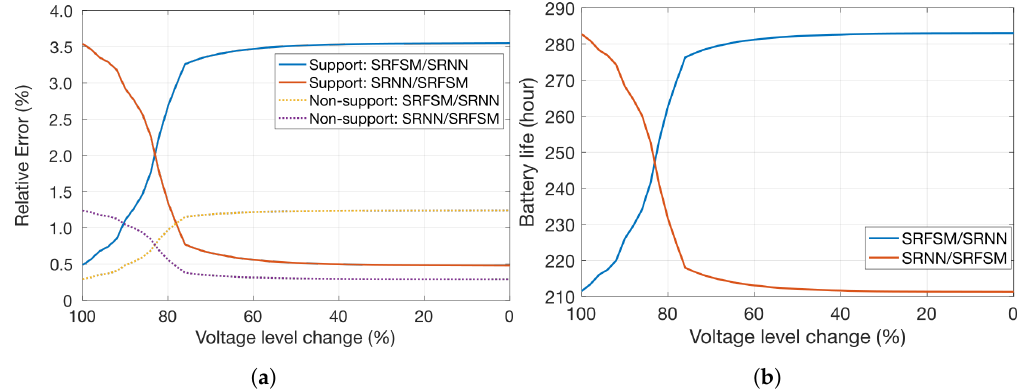
Figure 7. Relative error and Battery life of DA-FSM/NN. ( a ) Relation between relative errors on support and non-support parameters and the voltage level. ( b ) Relation between battery life (hours) and the voltage